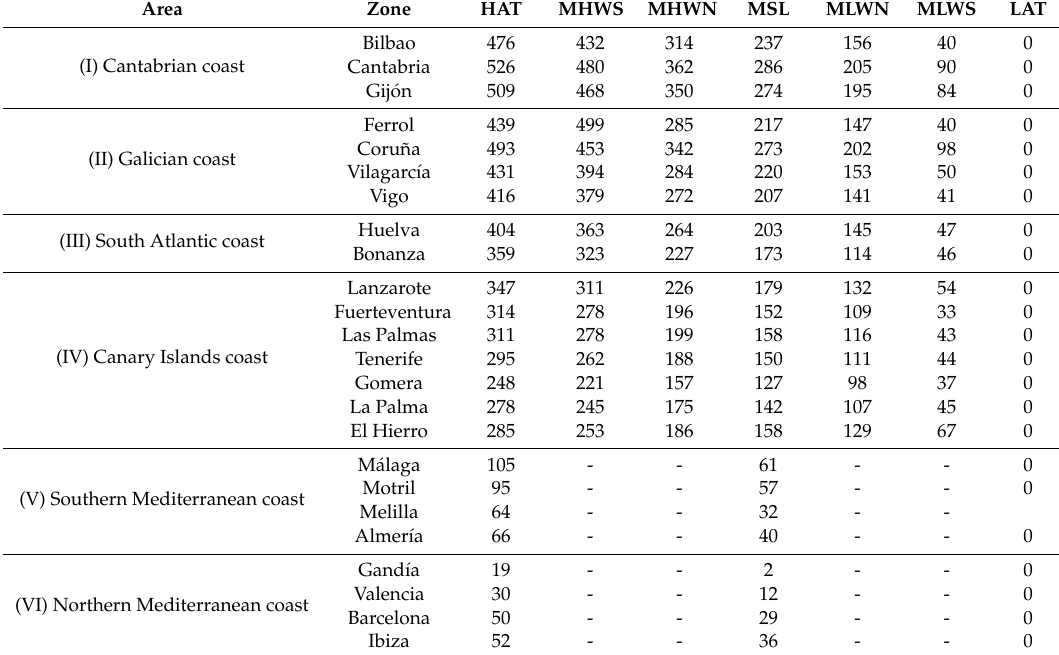
Table 3. Tidal data, in cm, in all the areas in the Spanish coast.